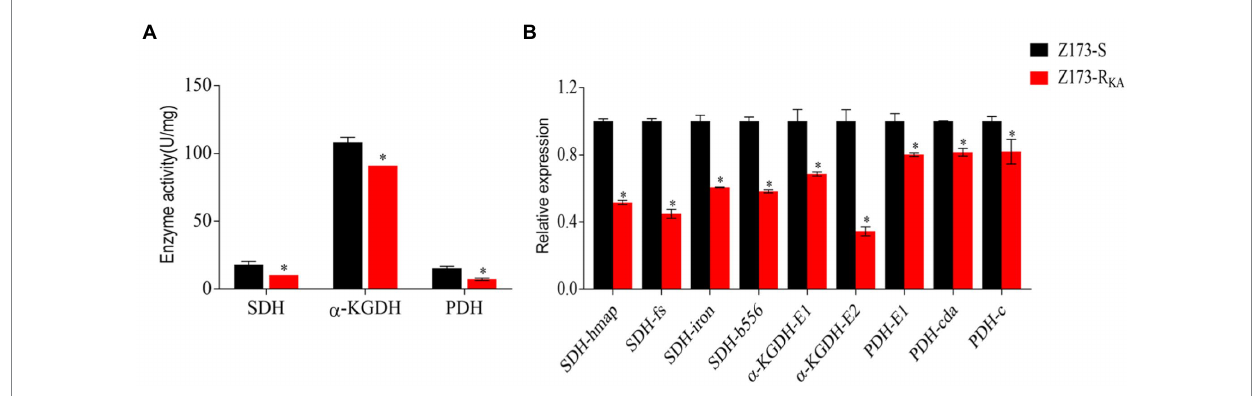
FIGURE 4 The depression of P cycle. (A) Enzymatic activities of SDH, α -KGDH and PDH of Z173-S and Z173-R KA . (B) Quantitative real-time PCR for gene expression of the P cycle. Results are reported as mean ± SD, and p -values are identified (* p < 0.05) as determined by the two-tailed Student’s t -test. At least three biological repeats were carried